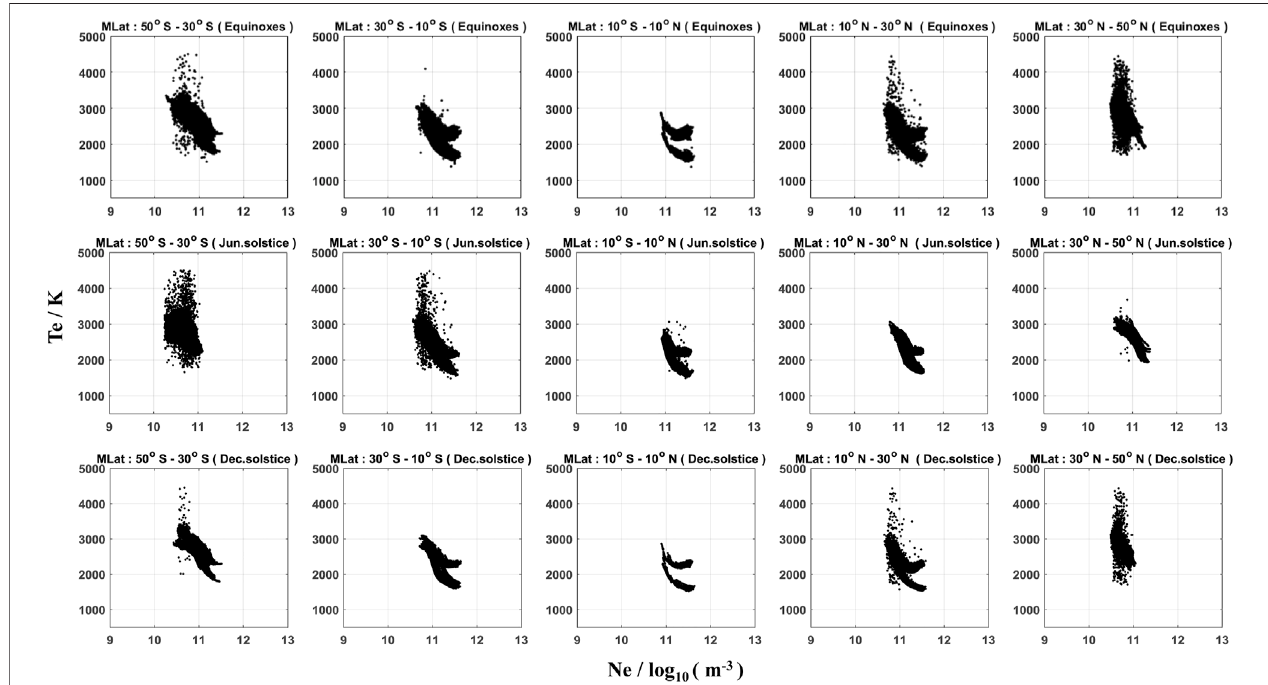
FIGURE 7 | As same as for Figure 5 , but for Swarm A.